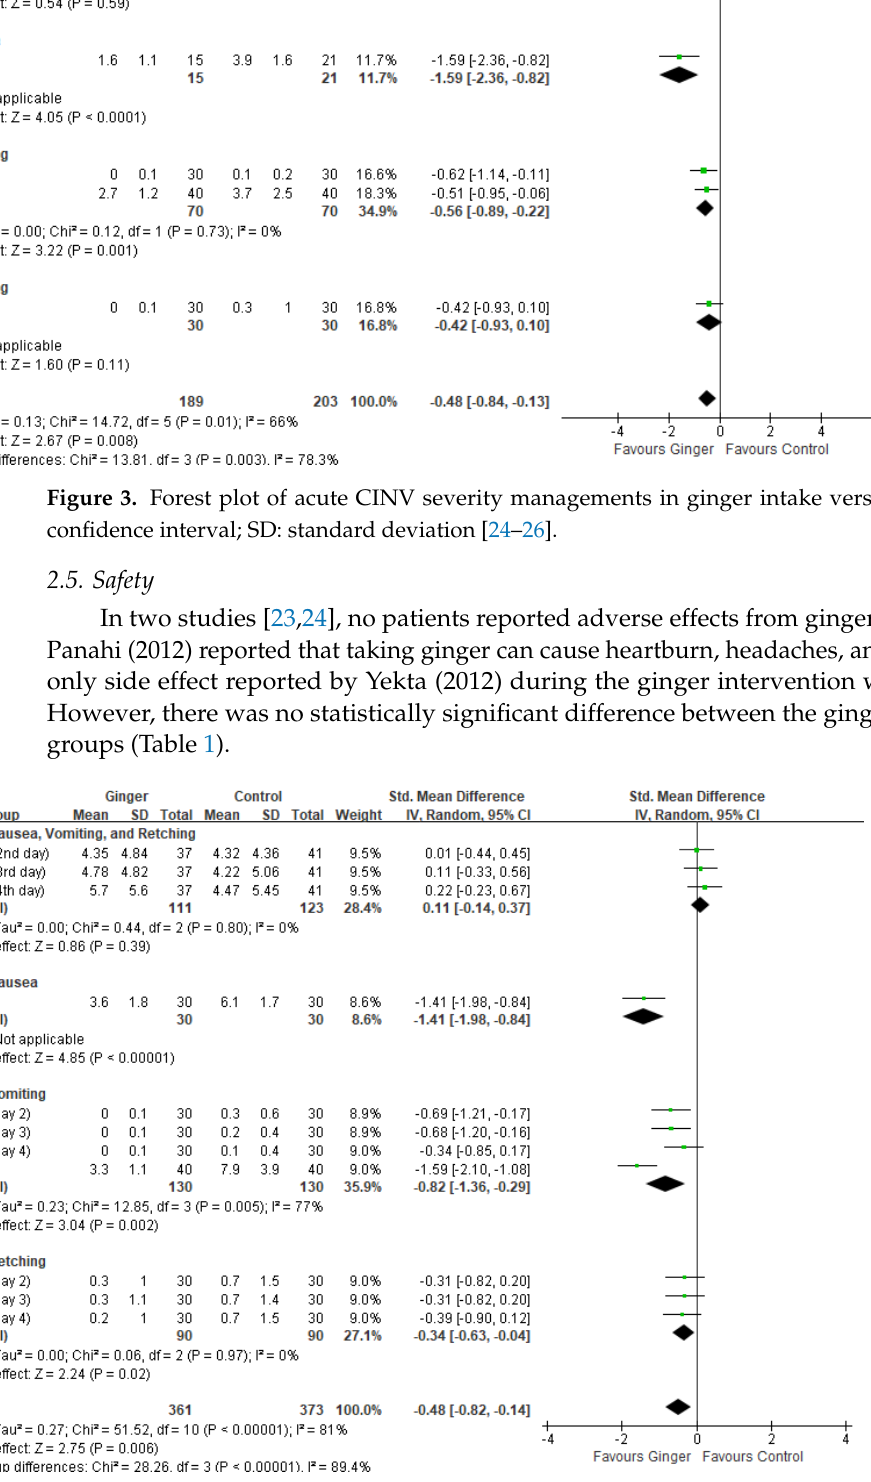
Figure 4. Forest plot of delayed CINV severity managements in ginger intake versus controls. CI: confidence interval; SD: standard deviation [24–26].